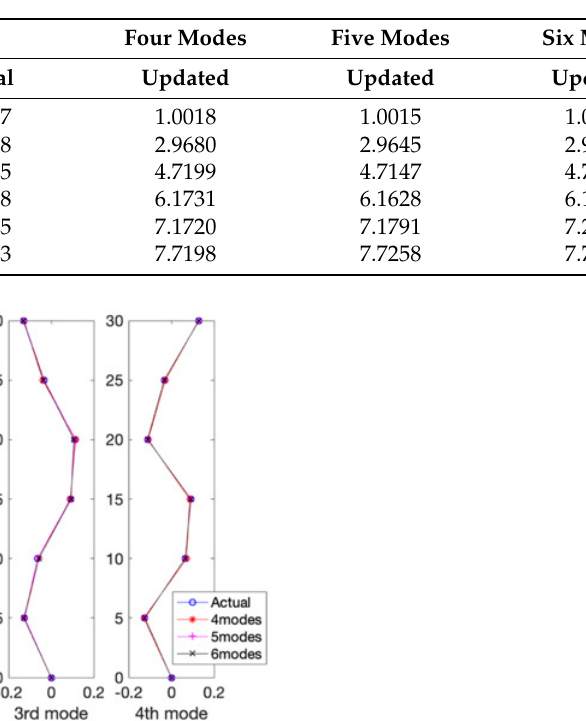
Table 1. Results of updated frequencies (Hz).